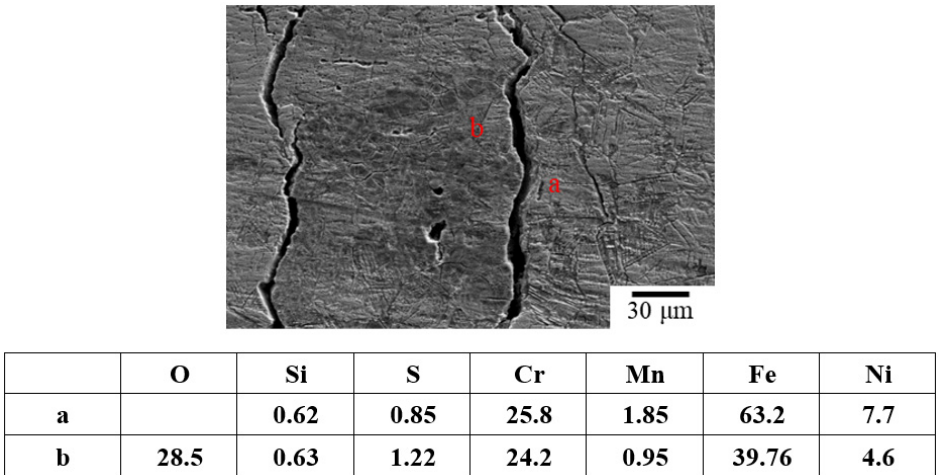
Figure 12. The oxide films at the specimen surface around the cracks were examined by the EDX technique.